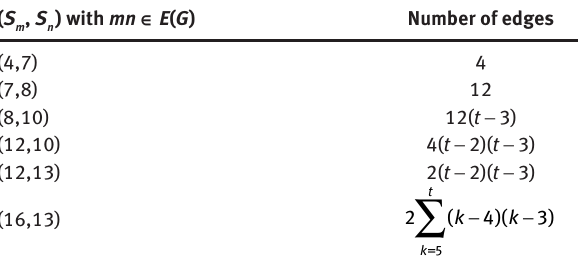
Table 4: The quantity of ( S of degrees of all neighboring vertices of the end vertices of each